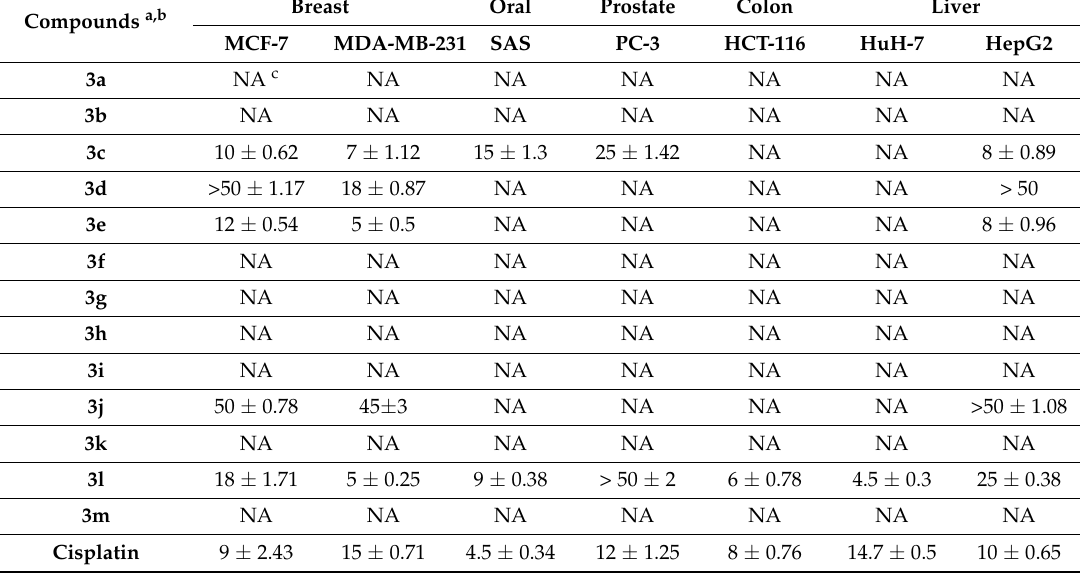
Table 2. The cytotoxic activities of the test compounds against seven cancer cell lines representing five different types of cancers (breast, tongue, prostate, colon and liver). Cell viability was evaluated with the MTT assay and the IC 50 ( µ M) value was calculated. The values are represented as the mean ± standard deviation from three independent experiments. NA indicates that the compounds were not active during the initial screening of their anticancer activities using crystal violet assay. Breast Oral Prostate Colon Compounds a,b